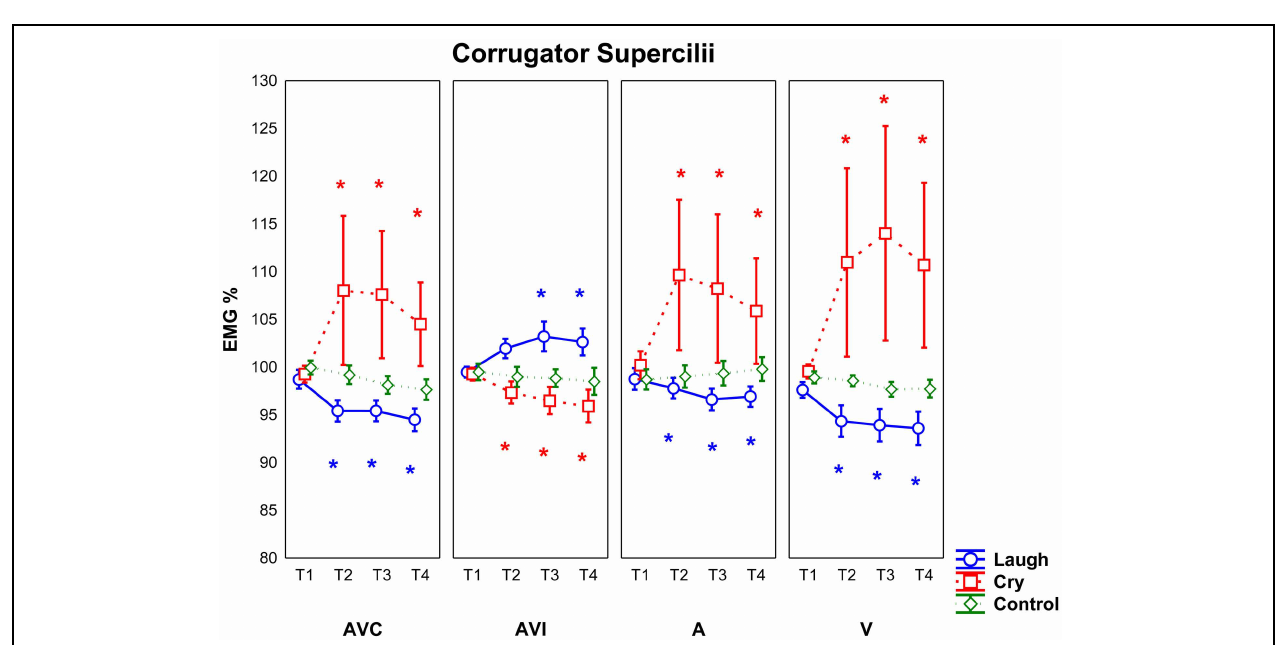
FIGURE 4 | Mean EMG responses recorded for Corrugator Supercilii muscle for all participants (SZP, CNT). All other conventions as in Figure 3 .